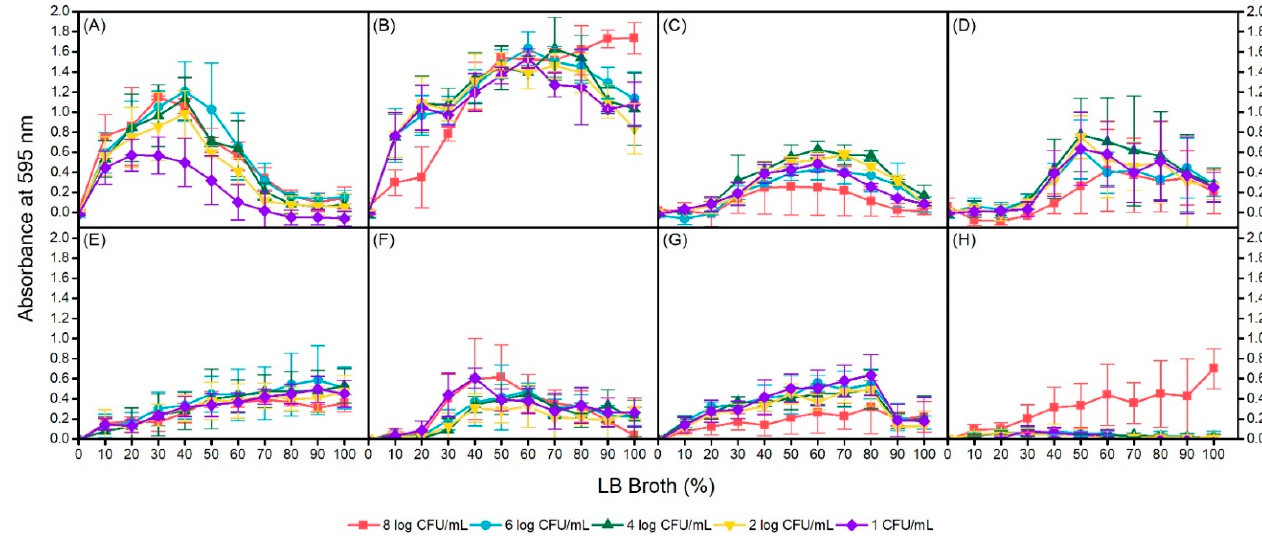
Figure 4. Biofilm formation in heat resistant Escherichia coli environmental isolates AW1.7 at 24 °C ( A ) and 37 °C ( B ); 53 at 24 °C ( C ) and 37 °C ( D ); 63 at 24 °C ( E ) and 37 °C ( F ); and clinical isolate 111 at 24 °C ( G ) and 37 °C ( H ) under conditions of inoculum size and nutrient concentration manipulation. Data presented as means ± standard deviations of triplicate experiments. Table 2. Multivariate linear regression analysis of factors associated with biofilm formation in Escherichia coli isolates.